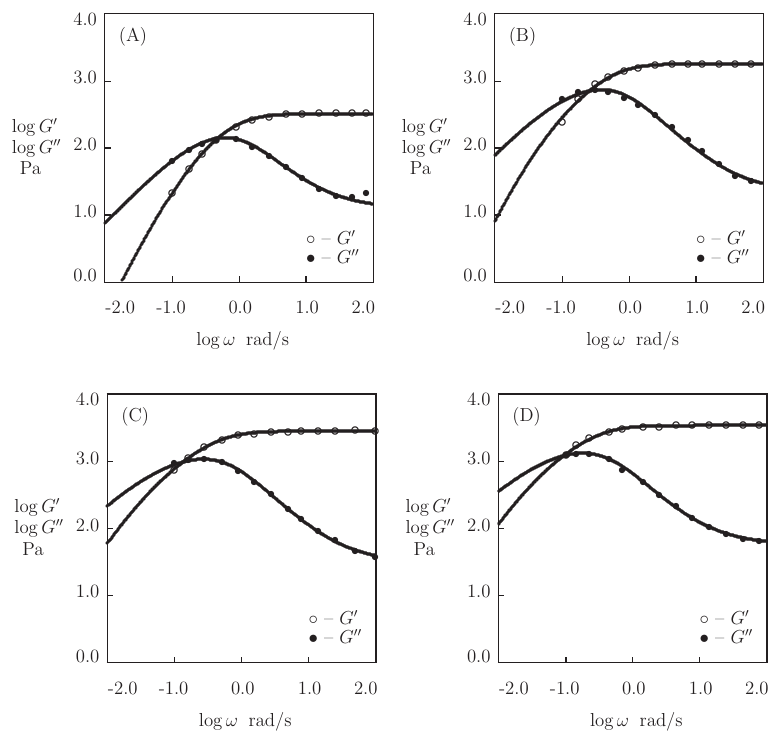
Figure 12. Storage modulus G (cid:48) and loss modulus G (cid:48)(cid:48) versus frequency ω . Symbols: experimental data [76] on CCK-CCE gels with various concentrations of proteins φ (( A )– φ = 0.04, ( B )– φ = 0.10, ( C )– φ = 0.13, ( D )– φ = 0.16)). Solid lines: the results of simulation.